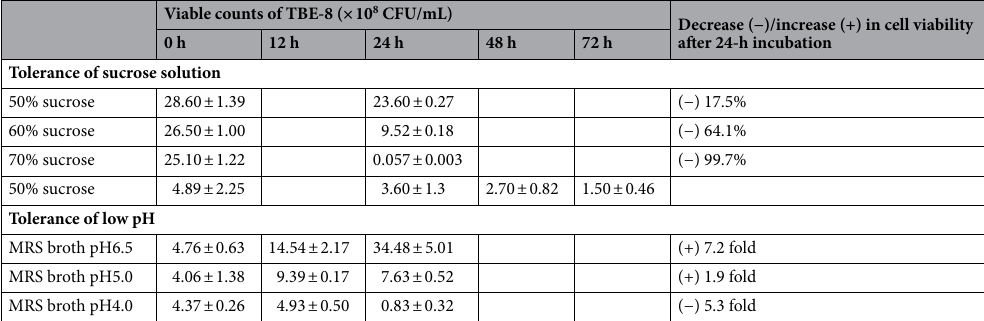
Table 3. Viability of Leuconostoc mesenteroides TBE-8 after incubation with different sucrose syrup concentrations at different pH conditions. *Each value in the table represents the mean value ± standard deviation (SD) from three